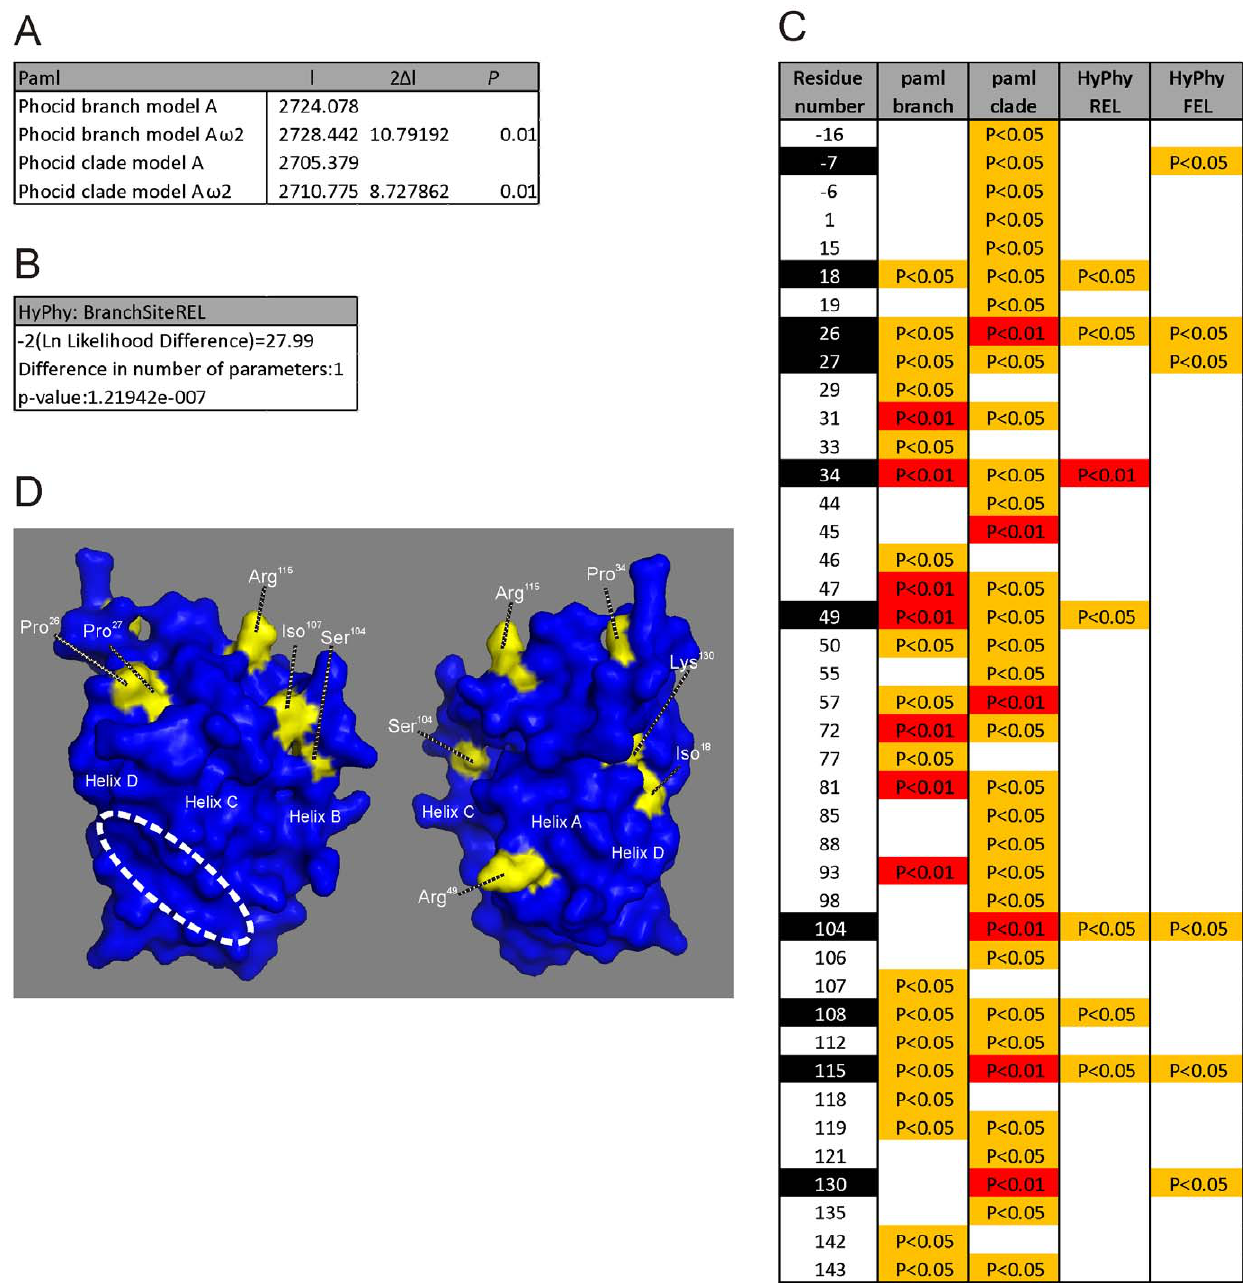
Figure 4. Positively selected residues in the phocid seal leptin occur away from the LEPR binding cleft. Likelihood ratio test statistics generated from the PAML branch model (A) and the REL analysis implemented using HyPhy (B) using the phocid branch of the tree. C shows the residues predicted to be under positive selection and statistical support by Bayes Empirical Bayes implemented in PAML and HyPhy REL and FEL analysis. D. Two views of the grey seal leptin with the selected residues identified in yellow and individually labelled. The positions of the A, C and D helices are indicated. The position of the hydrophobic binding cleft is identified with the white ellipse.